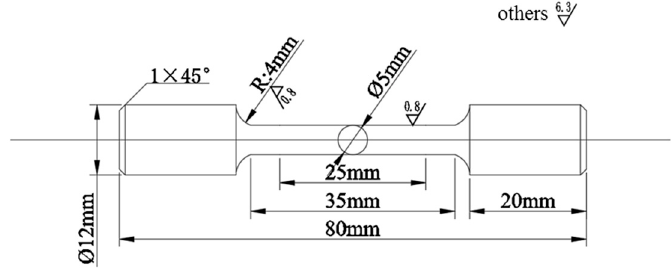
Figure 1. Drawing of the tensile specimen dimensions.